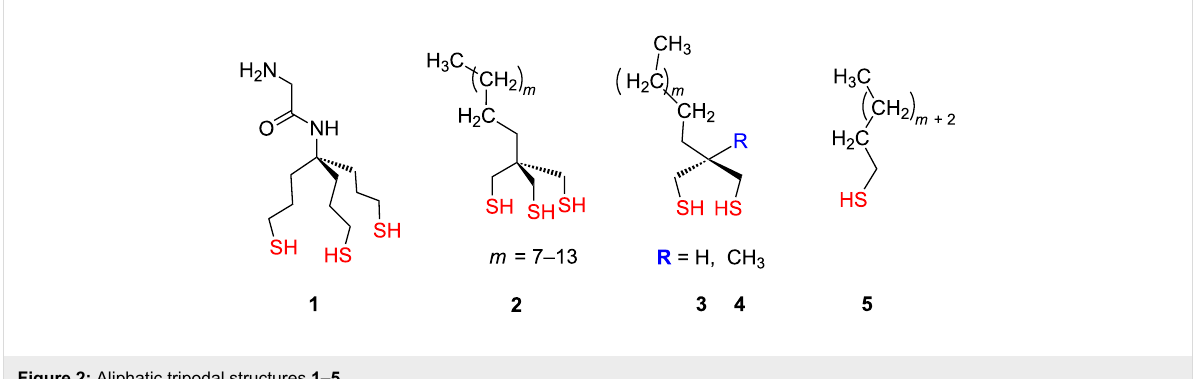
Figure 2: Aliphatic tripodal structures 1–5 .